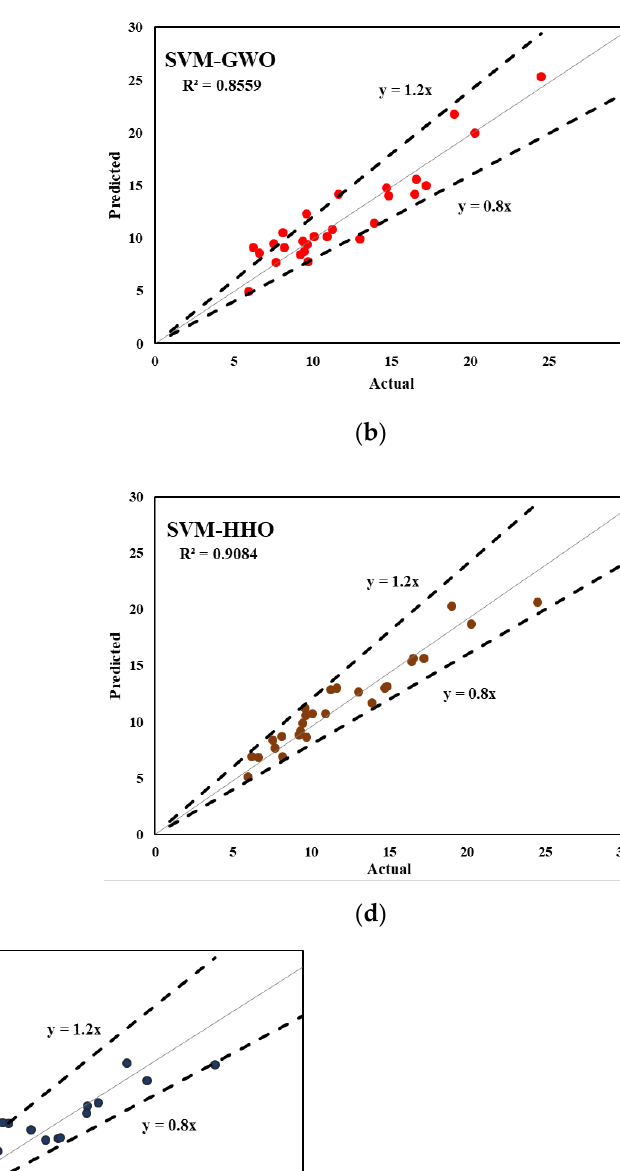
Figure 5. Actual vs. predicted graphs for the training dataset; ( a ) SVM-PSO ( b ) SVM-GWO ( c ) SVM- EO ( d ) SVM-HHO ( e ) SVM-SMA.